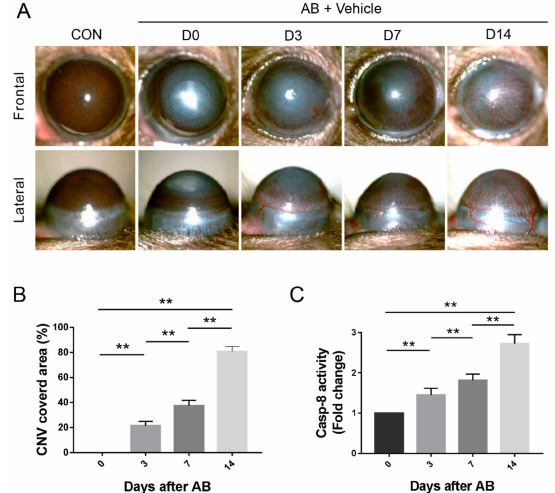
Figure 1. Corneal alkali burn (AB)-induced corneal neovascularization (CNV) and increased caspase-8 activity. ( A ) Representative photos of mouse eyes at 0, 3, 7, and 14 days after corneal AB injury. ( B ) Statistical analysis of the CNV covered area at various time-points ( n = 6). (C) Colorimetric assay of caspase-8 activity in corneas ( n = 3). The data are presented as the mean ± SD. ** p < 0.01. Abbreviations: CON, control; Casp,